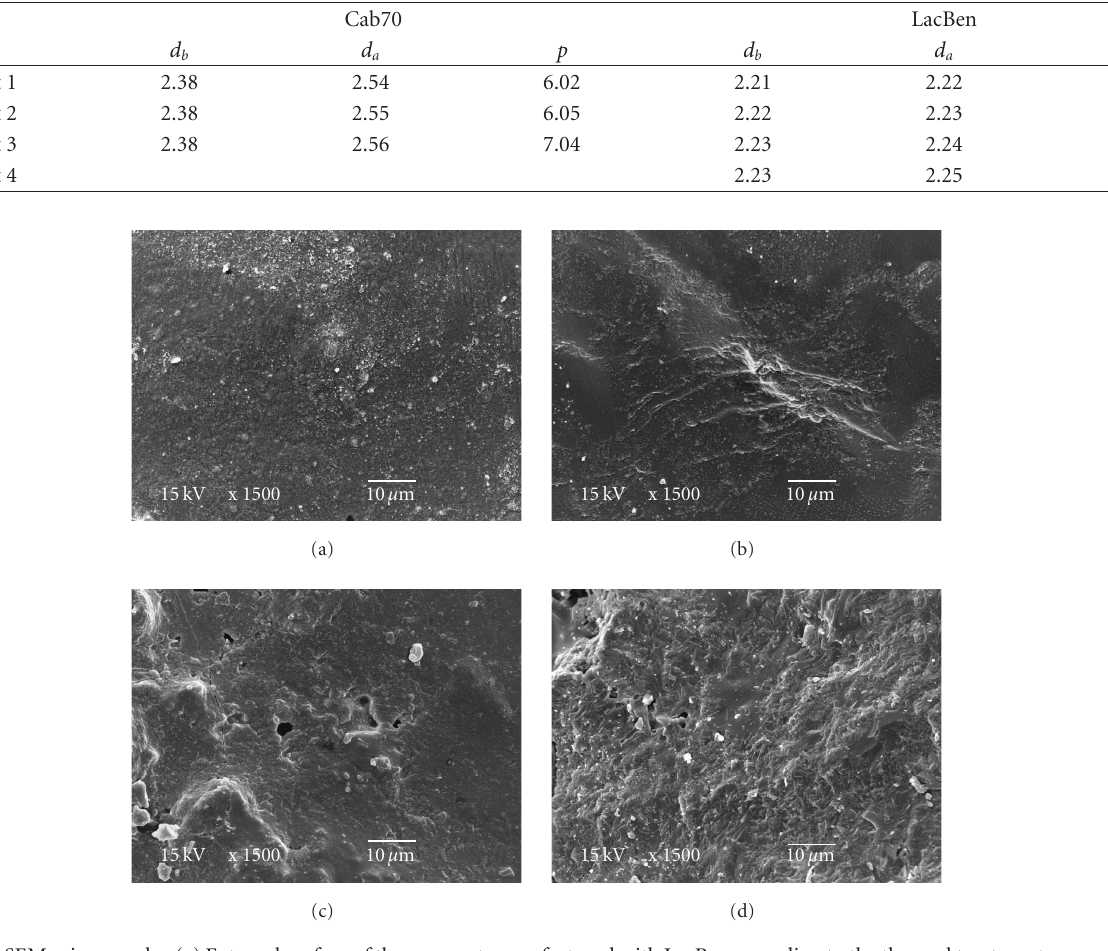
Figure 4: SEM micrographs: (a) External surface of the compact manufactured with LacBen according to the thermal treatment summarised in Table 1g, (b) internal surface of the same compact, (c) External surface of the compact manufactured with Cab70 according to the thermal treatment summarised in Table 1f, (d) internal surface of the same